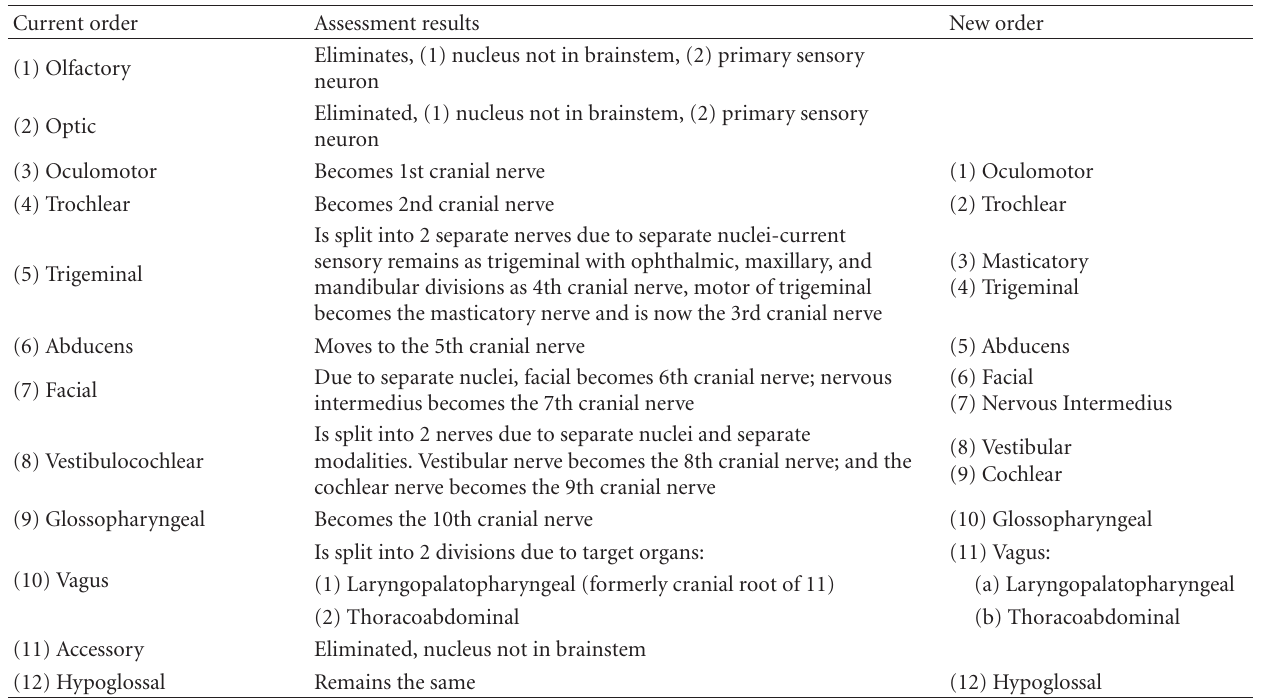
Table 2: Renumeration of cranial nerves following the application of the definition of a cranial nerve. To be defined as a cranial nerve the nuclei must originate from the brainstem, communicate with a foramen of the skull and secondary neuron whose cell bodies are located in the brainstem. This criteria still produced 12 cranial